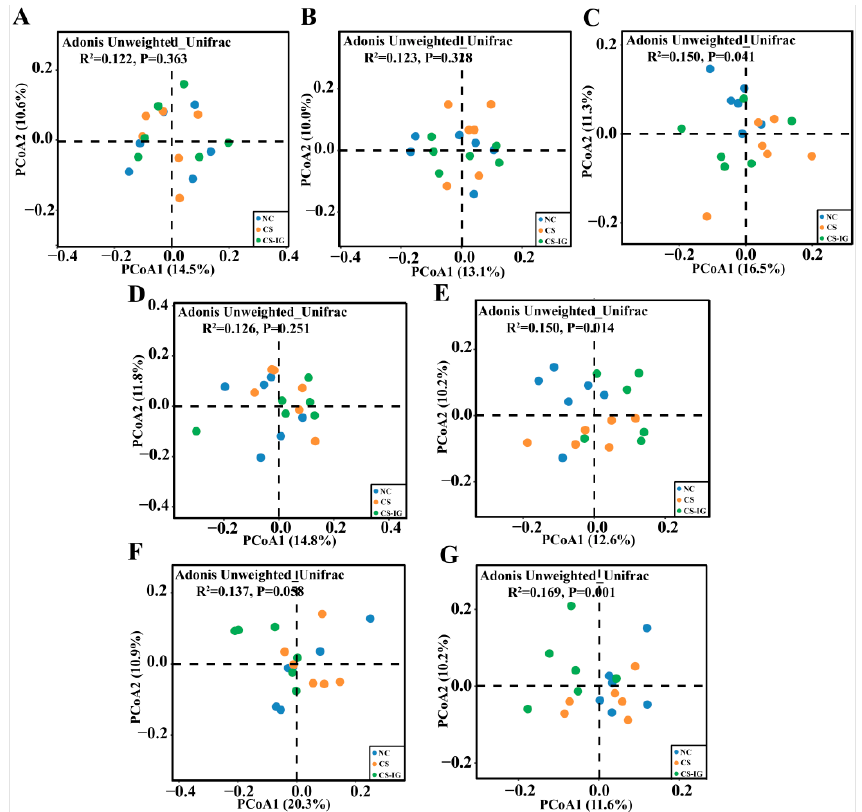
Figure 3. The effects of cigarette smoke exposure and intragastric administration of strain JQ581 on the structure of gut microbiota. Principal coordinate analyses (PCoAs) based on ASVs of feces, colon, and cecal contents in mice are shown. (A-C) PCoAs of feces collected at 0 ( A ), 6 ( B ), and 12 ( C ) weeks after treatment. ( D , E ) PCoAs of colon collected at 6 ( D ) and 12 ( E ) weeks after treatment. ( F , G ) PCoAs of cecal contents collected at 6 ( F ) and 12 ( G ) weeks after treatment. NC, mice treated with normal air exposure; CS, mice treated with cigarette smoke exposure; CS-IG, mice treated with combination of cigarette smoke exposure and intragastric administration of nicotine-degrading strain